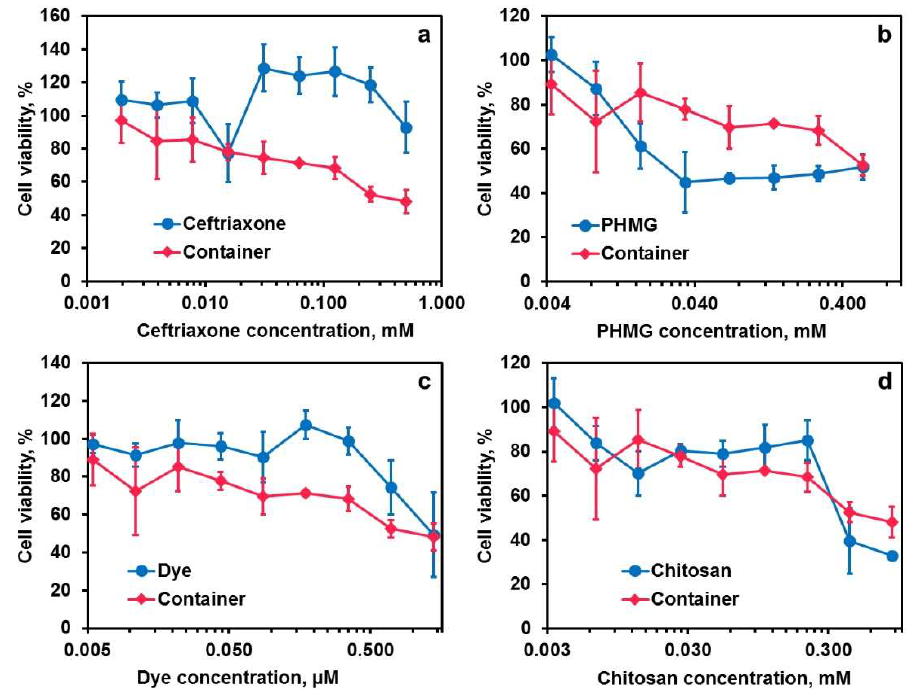
Figure 9. Cytotoxic activity of the chitosan containers with PHMG–ceftriaxone–dye (red lines) shown together with the graphs for free ceftriaxone alone ( a ), free PHMG alone ( b ), free dye alone ( c ) and free chitosan alone ( d ) on the MCF7 cell line after 24 h of incubation. Each value represents the mean ± SD ( n = 3).